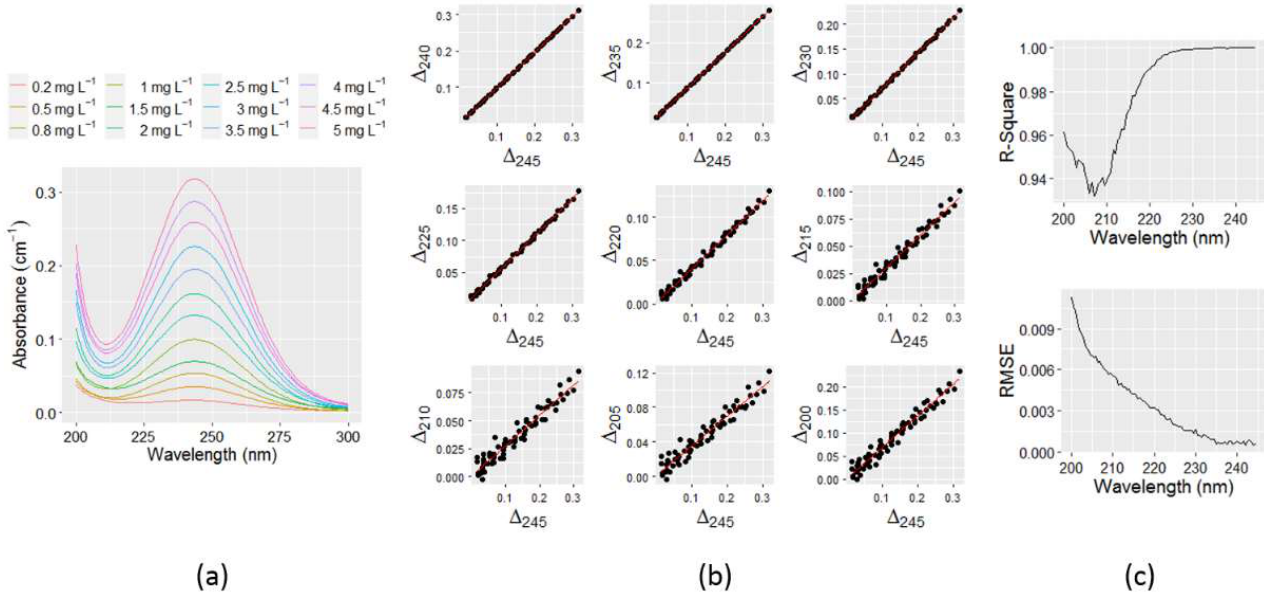
Figure 4. ( a ) Pure monochloramine spectra in Milli-Q water with different concentrations, ranging from 0.2 mg L − 1 to 5.0 mg L − 1 ; ( b ) plot of absorbance difference at various wavelengths against the same at 245 nm; and ( c ) R 2 and RMSE values in linear model fit between ∆ 245, ltrapure and ∆ i, ultrapure .